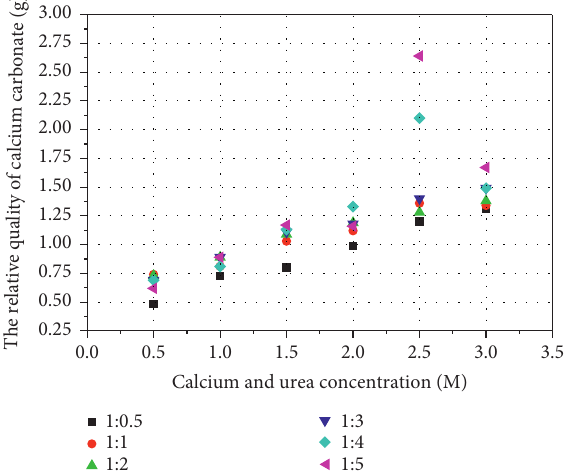
Figure 8: The relative quality of calcium carbonate at different calcium and urea concentration sources.